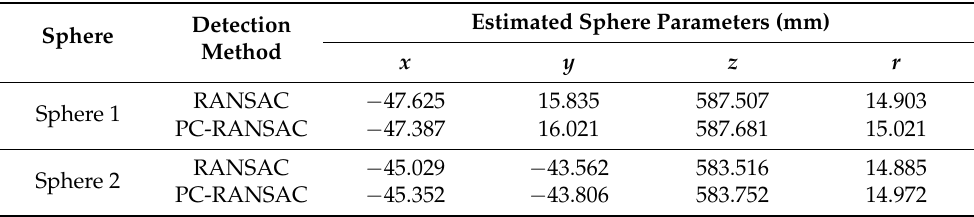
Table 2. Sphere detection results of the data for each method.